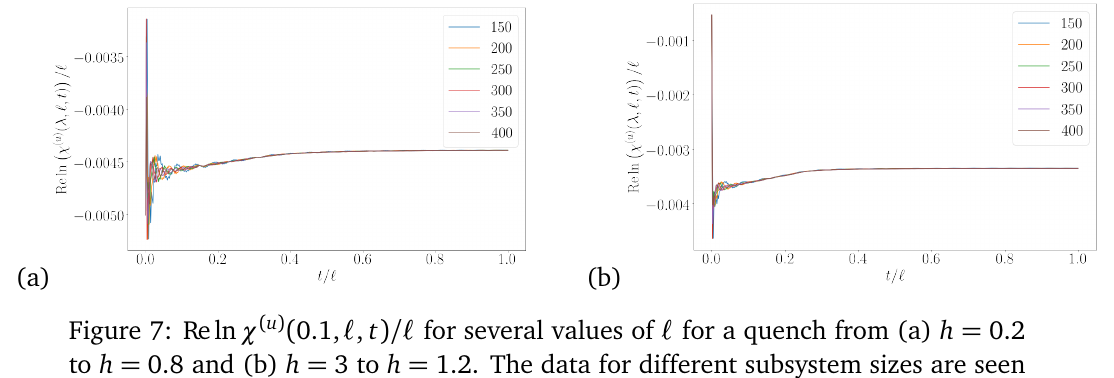
Figure 7: Reln χ ( u ) ( 0.1, (cid:96) , t ) /(cid:96) for several values of (cid:96) for a quench from (a) h = 0.2 to h = 0.8 and (b) h = 3 to h = 1.2. The data for different subsystem sizes are seen to collapse at sufficiently late